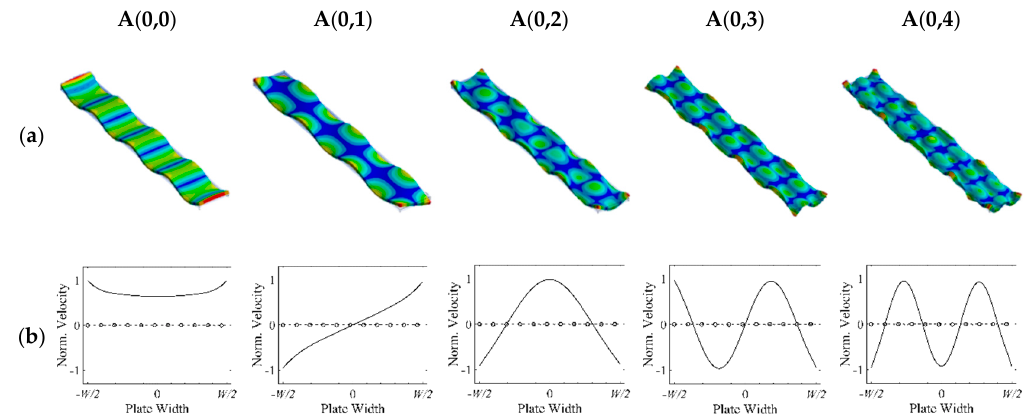
Figure 3. ( a ) Wave structures and ( b ) particle velocity profiles (width direction) of the A(0, n ) modes in a SS304 plate with 1.5 mm thickness and 15 mm width at 1.0 MHz; the velocity profiles are extracted on the neutral plane ( z = 0); solid line: out-of-plane direction ( z direction); dashed line: in-plane horizontal direction ( y direction); circle markers: in-plane extensional direction ( x direction).